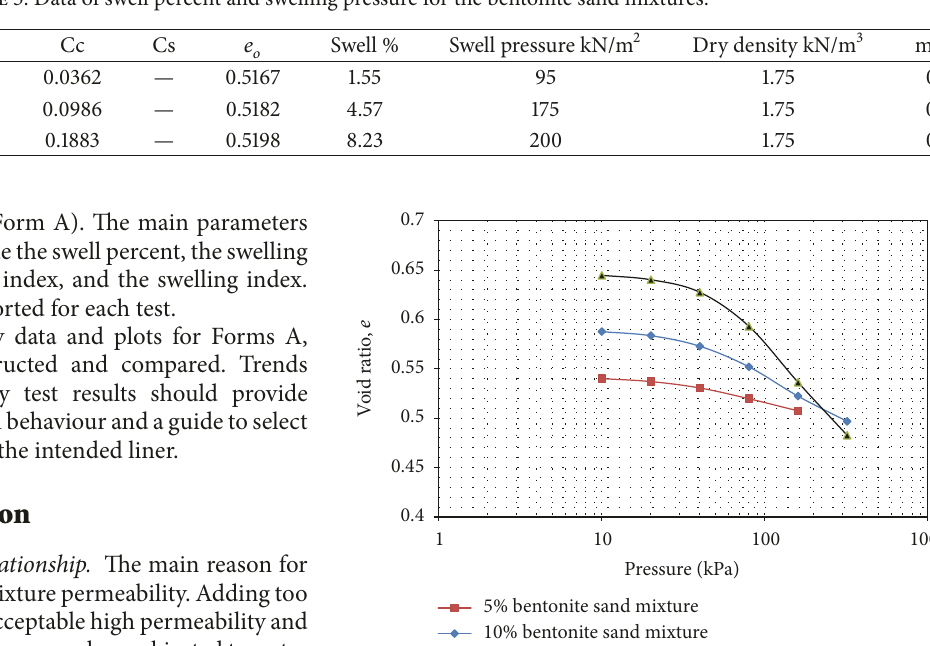
Table 5: Data of swell percent and swelling pressure for the bentonite sand mixtures.